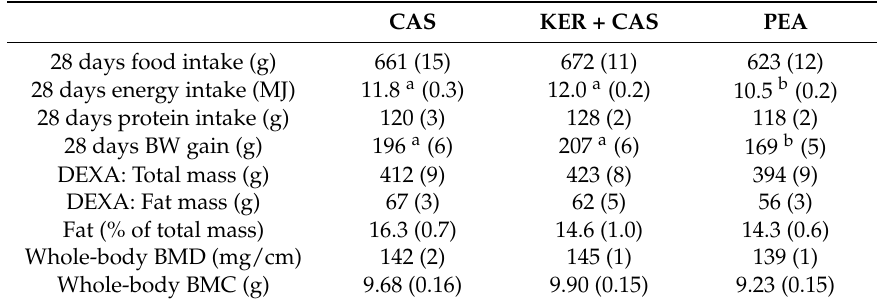
Table 3. Food intake, body weight gain, and dual-energy X-ray absorptiometer (DEXA) body scan data from rats after 4 weeks of being fed on test diets containing 18% w/w protein sourced from casein (CAS), 50:50 w/w keratin and casein (KER + CAS), or yellow pea flour (PEA) 1 . CAS